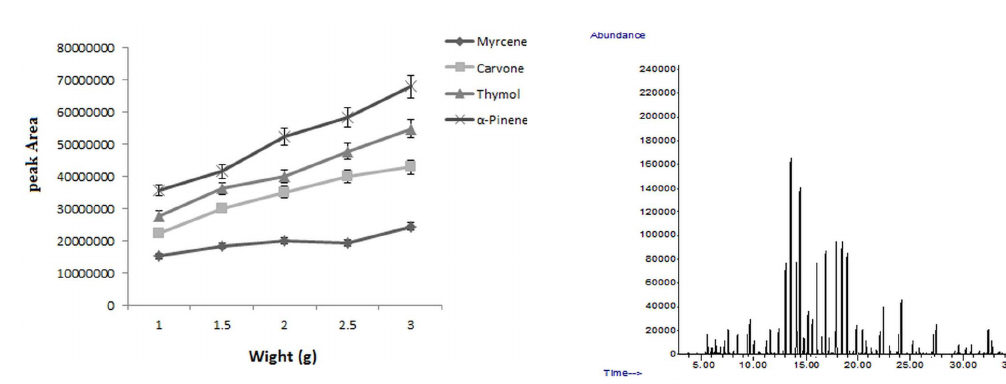
Fig. 2. Effect of extraction temperature on extraction efficiency. Fig 4 : GC chromatogram for volatile oils